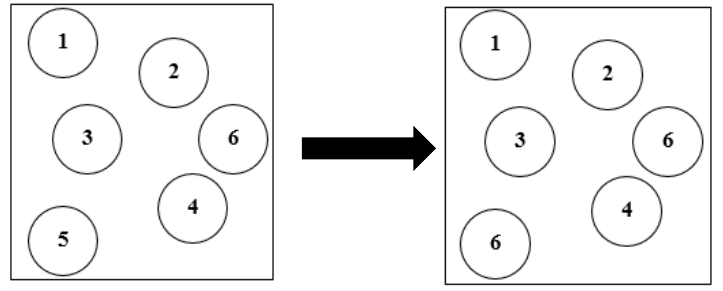
Figure 4. Dataset after being processed by bootstrap resampling.